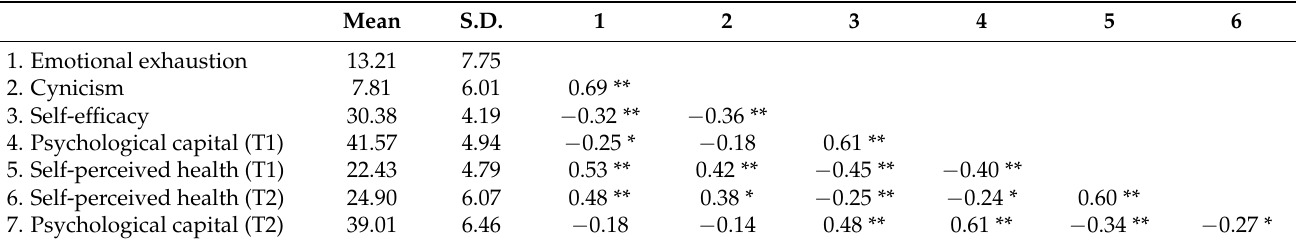
Table 1. Means, standard deviations, and correlations between the study variables.